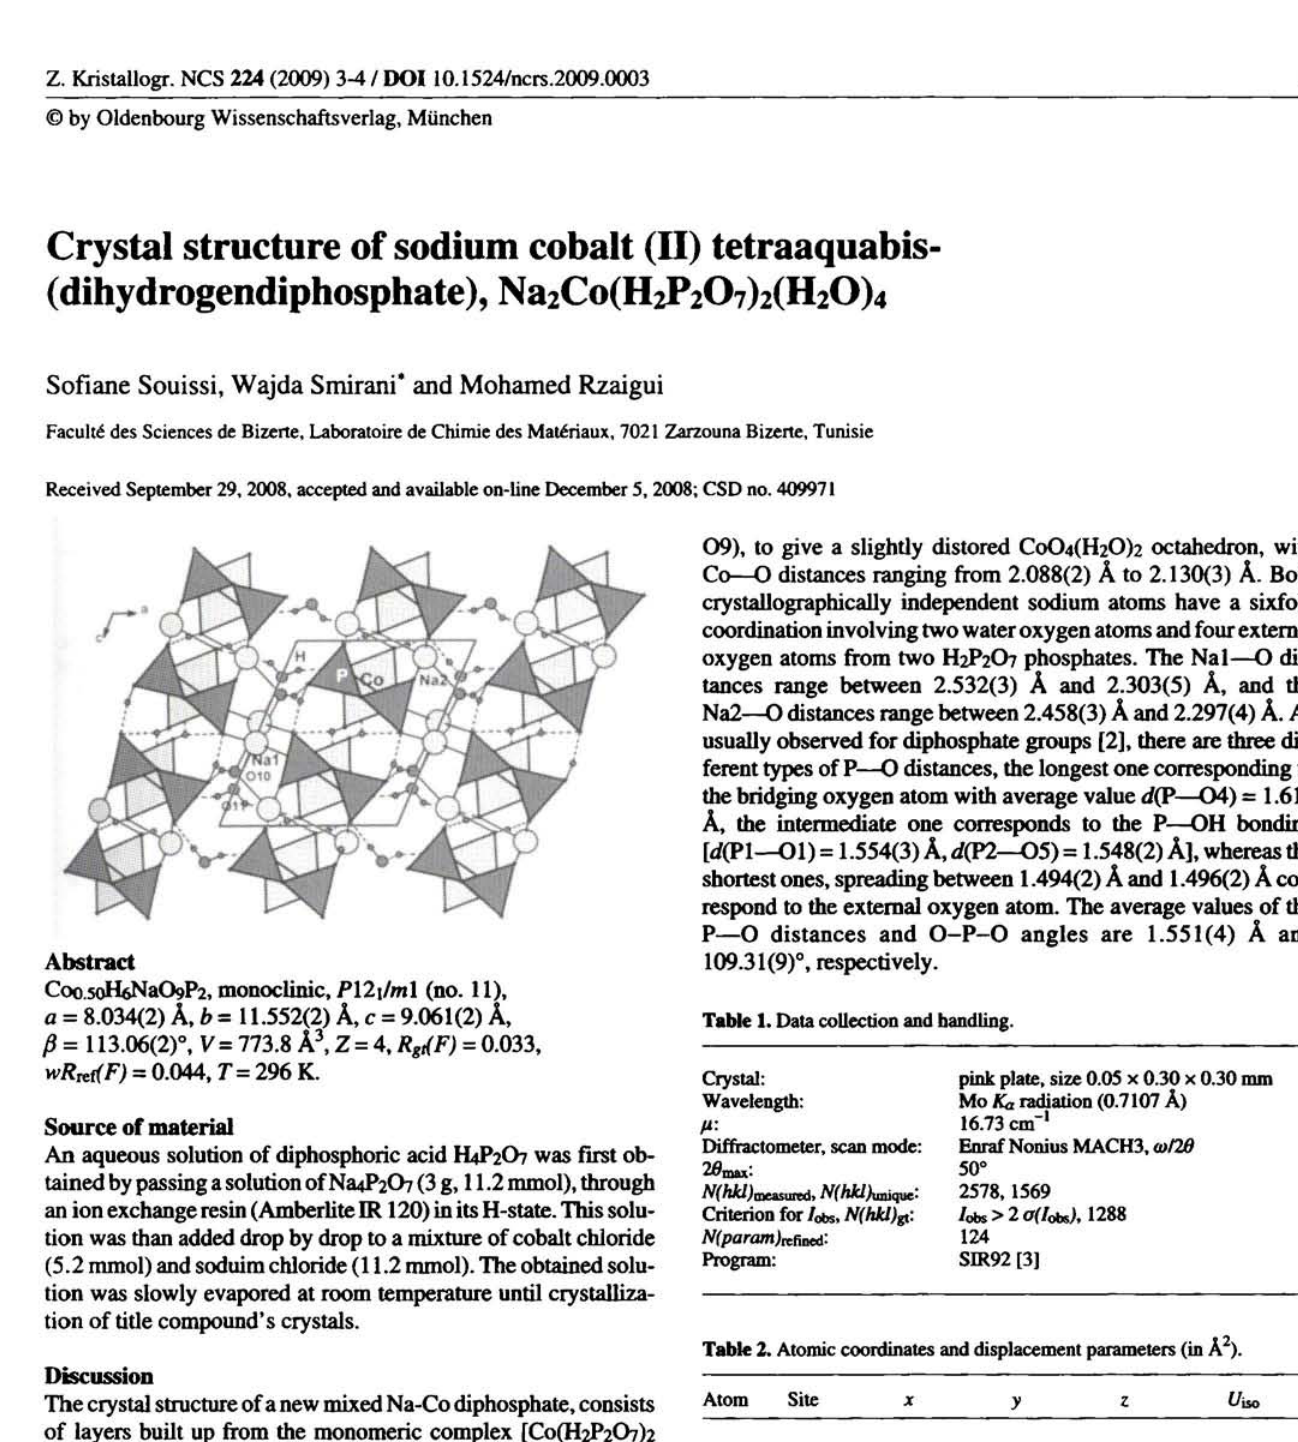
Table 2. Atomic coordinates and displacement parameters (in Â 2